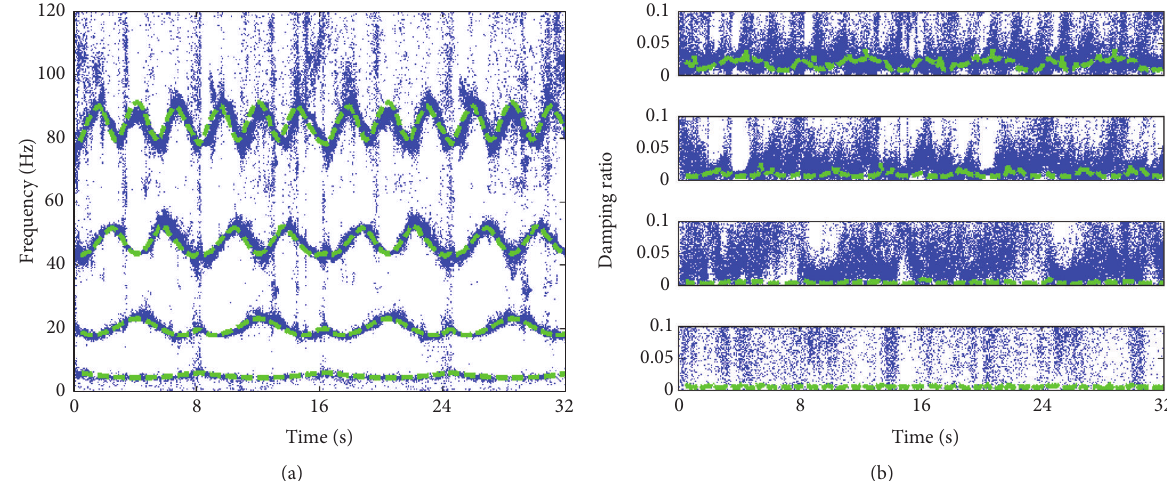
Figure 14: Exponentially weighted RPLR-TARMA based modal parameter Monte Carlo estimates (30 realizations): (a) natural frequency estimates and (b) damping ratio